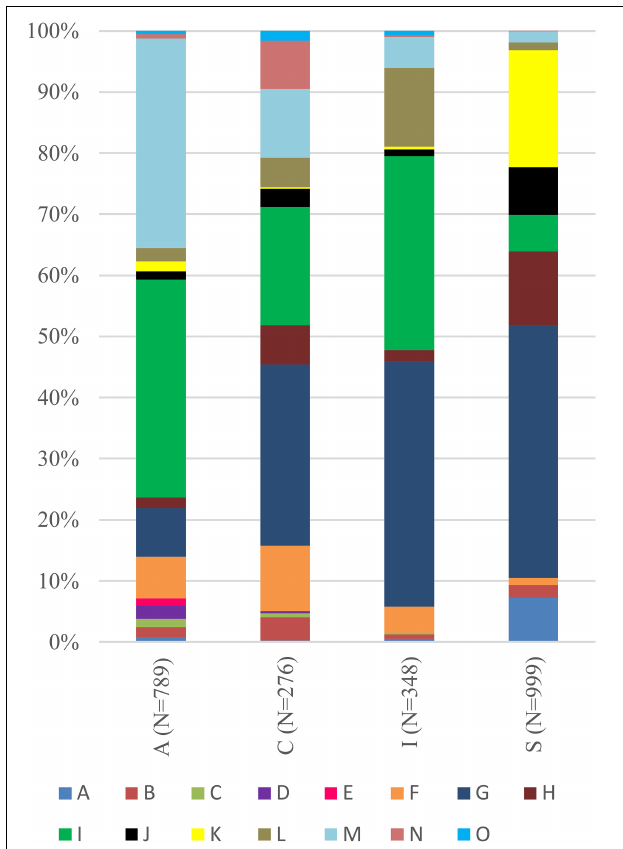
FIGURE 7 | Bar graphs of the percentage occurrence of particular groups of lichen secondary metabolites found in lichen thalli with identified Trebouxia photobionts belonging to clades A, C, I, and S. Symbols A–O correspond to groups of secondary metabolites: no substances (A), presence of aliphatic (fatty) acids (B), anthraquinones (C), ergochromes (D), depsones (E), orcinol depsides (F), β -orcinol depsides (G), orcinol depsidones (H), β -orcinol depsidones (I), orcinol tridepsides (J), pulvinic acid derivatives (K), terpenoids (L), usnic acid derivatives (M), xanthones (N), and pigments